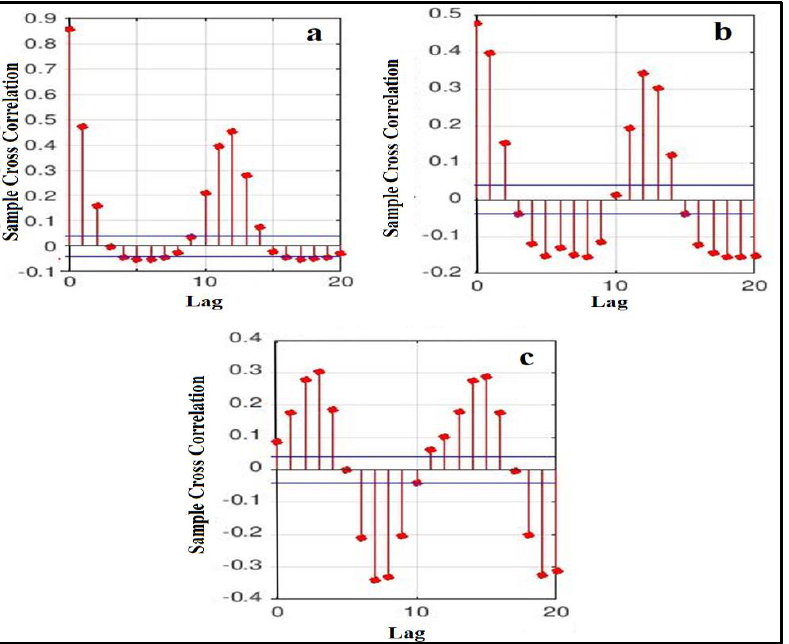
Figure 3. ACF of SSY for time series data with various time lags in MR basin.